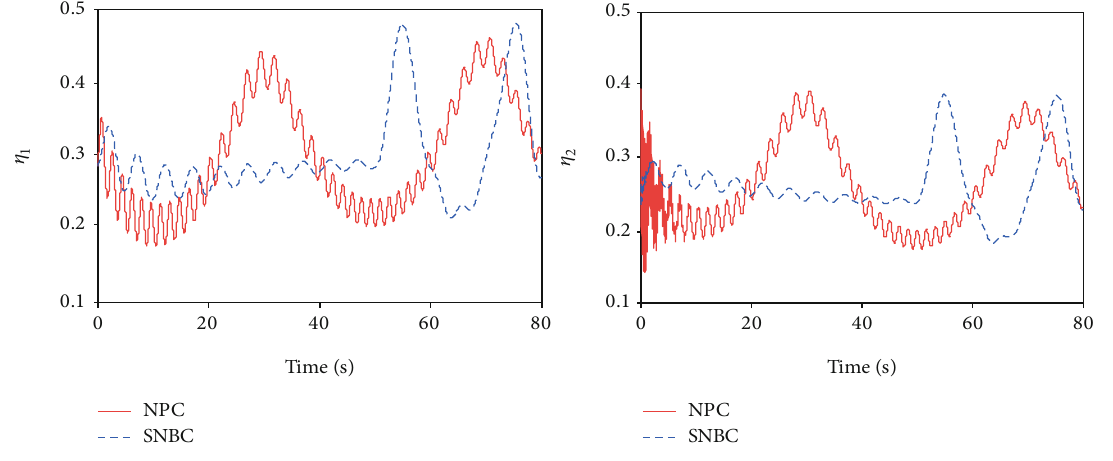
Figure 7: The fl exible states of the case.